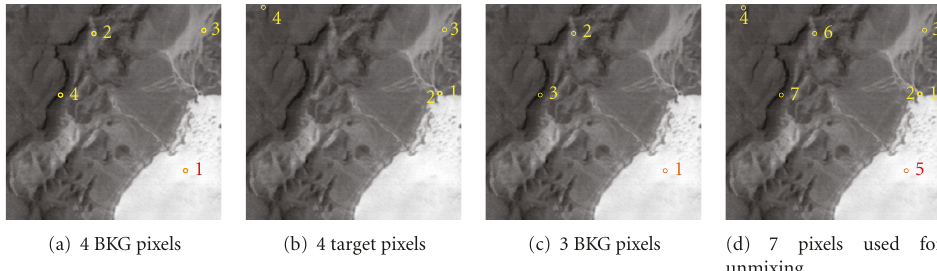
Figure 29: ATGP-USTFA generated BKG and target pixels (a) 4 BKG pixels in original data; (b) 4 target pixels in sphered data; (c) 1 BKG pixel not identified as target pixels; (d) 7 pixels obtained by combining the pixels in